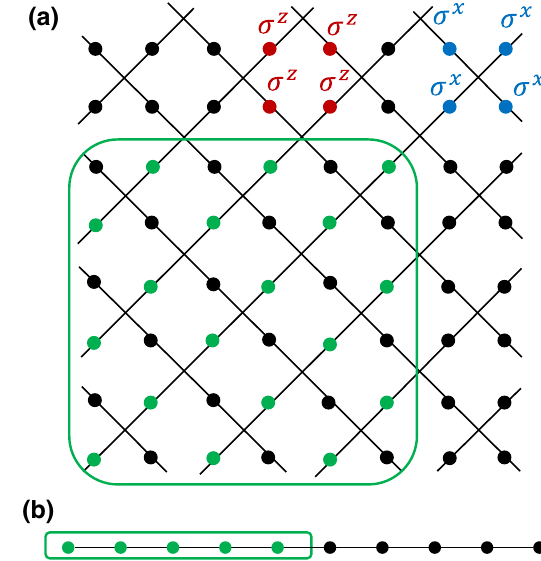
FIG. 3. (a) The toric code model on a square lattice. In blue is (cid:5) σ x , and in red an example an example of a star operator, (cid:5) i i ∈ s σ z . Circled in green is an example of a plaquette operator, i i ∈ p subsystem of dimensions w = 6, where the system is composed of the sites colored in green. (b) The XX model is defined on a finite one-dimensional chain, where subsystem A is its left half as circled and colored in